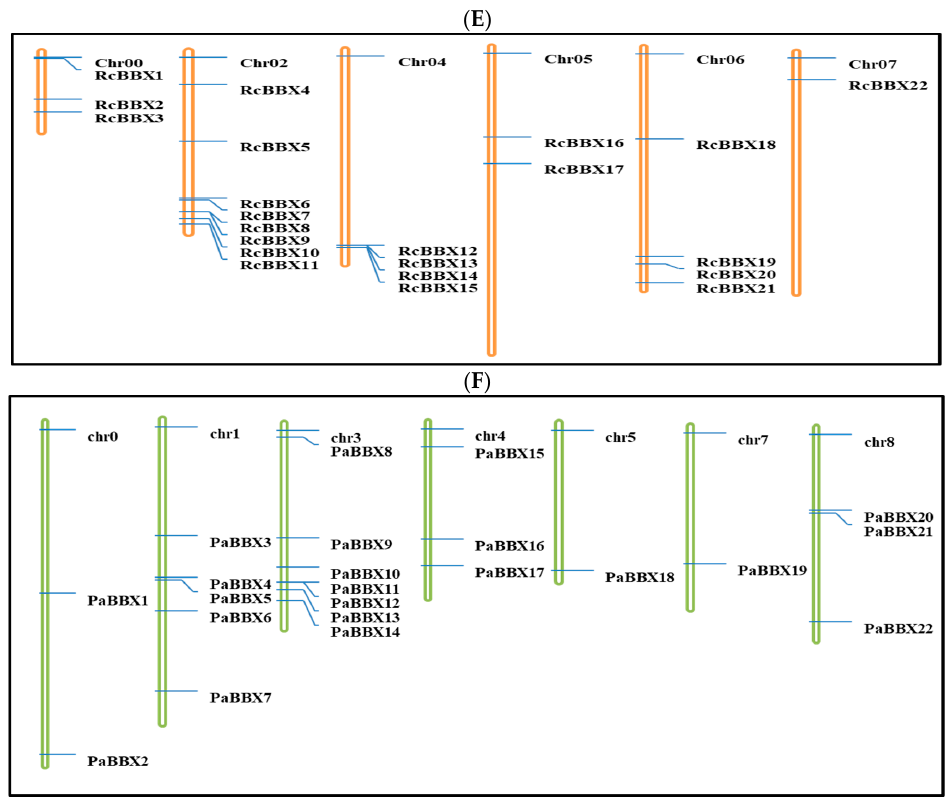
Figure 2. Chromosomal location of BBX genes on apple chromosomes. ( A ) Malus × domestica ; ( B ) Fragaria vesca ; ( C ) Rubus occidentalis ; ( D ) Prunus persica ; ( E ) Rosa Chinensis ; ( F ) Prunus avium , respectively. The graphical view was drawn from each gene ID and scaffolds information and position of each gene are indicated by a line.